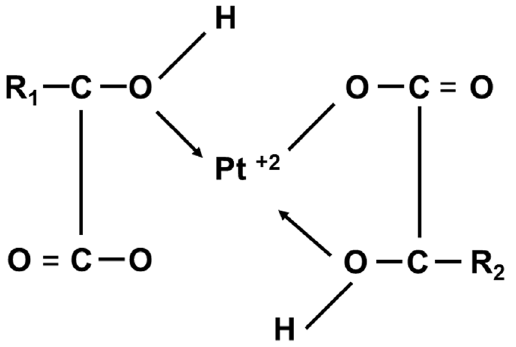
Figure 1. Chemical structure of BP-C1 analog. R1 and R2 represent any kind of chain.